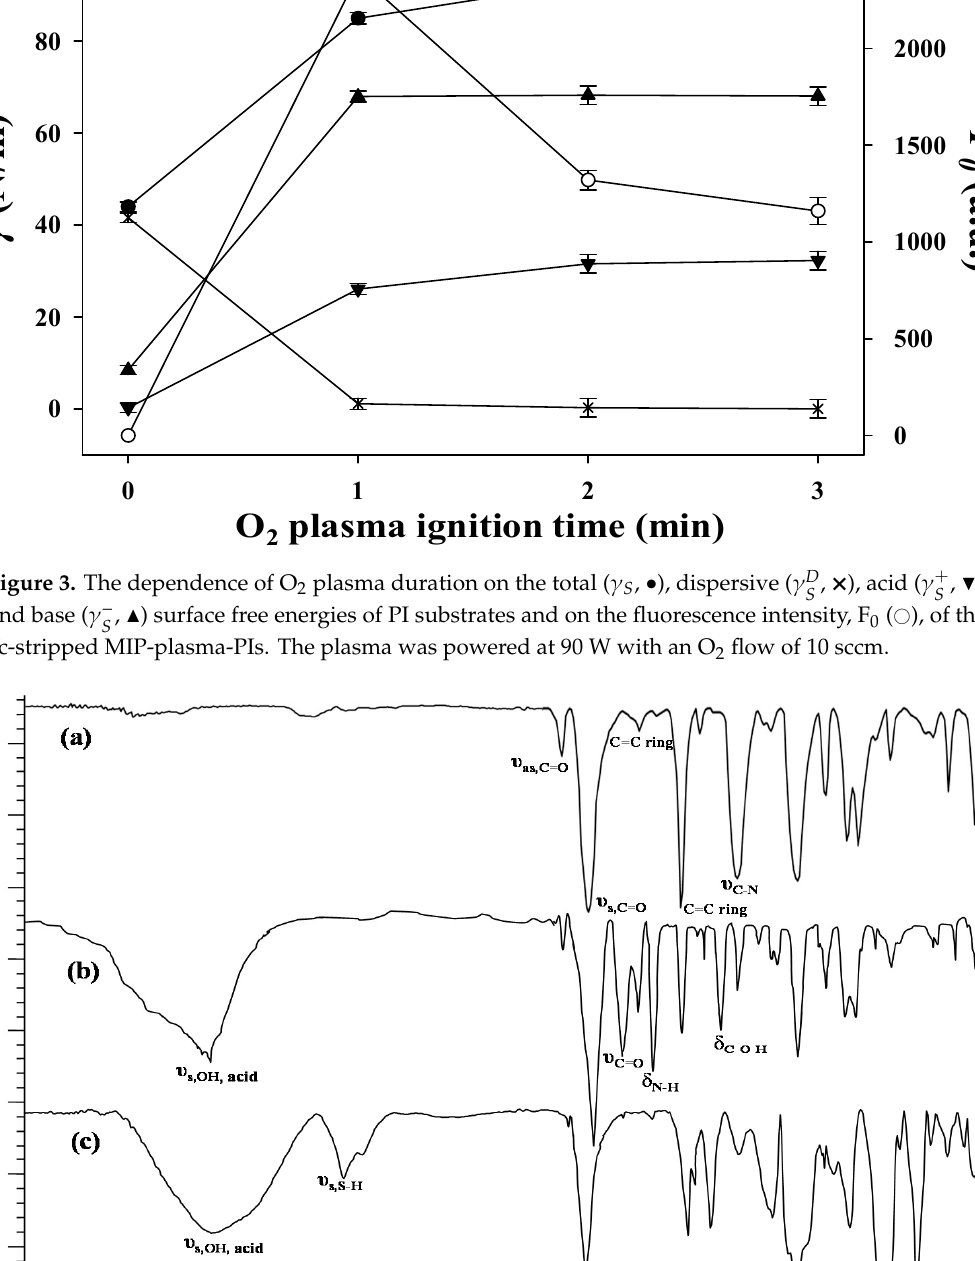
Figure 4. The Fourier transform infrared (FTIR) spectra of ( a ) intact PI, ( b ) plasma-treated PI, and ( c ) MIP-plasma-PI.